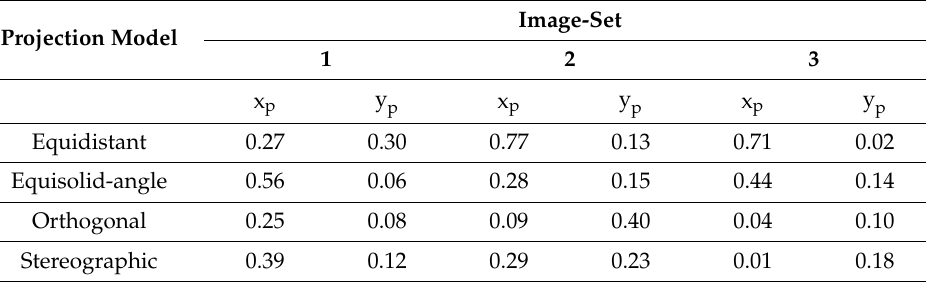
Table 20. Absolute error of principal point coordinates